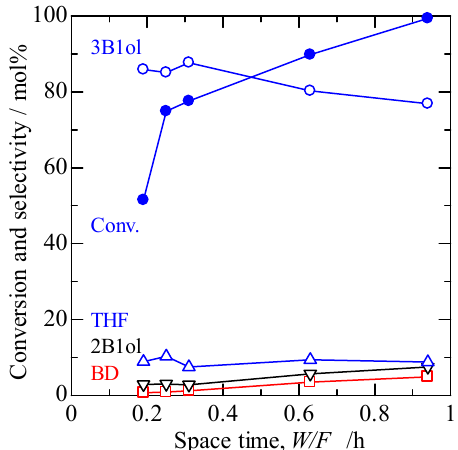
Figure 7. Change in the conversion of 1,4-BDO with space time over YZrO calcined at 900 ◦